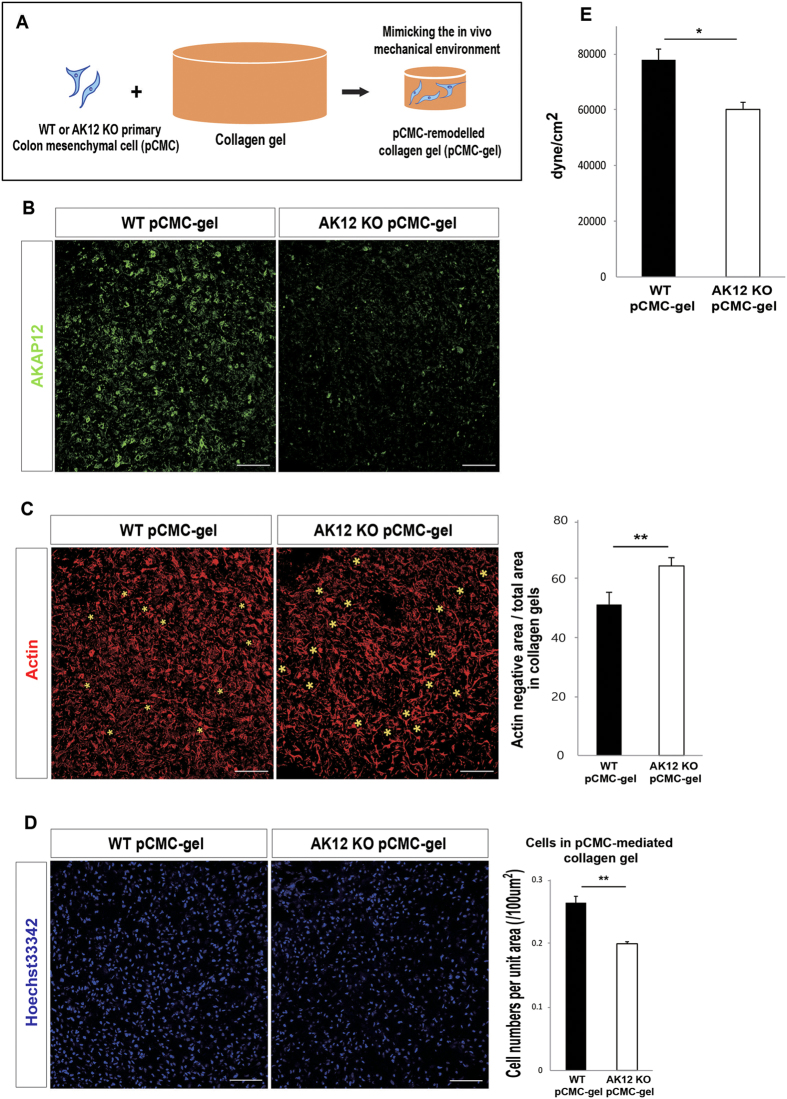
Mechanical difference between WT pCMC-gels and AKAP12 KO pCMC-gels.(A) Experimental design of collagen gel assay with pCMCs. To establish pCMC-gel, 7 × 105 WT or AKAP12 KO pCMCs were inserted in 3 mg/ml collagen gels, released from plate after incubated during 8 hr and then further incubated until 48 hr. (B) Immunostaining for AKAP12 in WT or AKAP12 KO pCMC-gels. Bars: 100 μm. (C) Actin negative area to total area of WT pCMC and AKAP12 KO pCMC-gels with was measured. Actin-negative area in representative images of each gels were marked by yellow asterisk with different size. Bars: 100 μm (D) Density of cells in collagen gels per each group were measured by calculate the number of cells per area. Bars: 100 μm (E) The storage modulus at 1% strain and at 1 Hz of fixed WT and AKAP12 KO pCMC-gels were averaged. (mean ± SEM, n = 6 per group). All panels, P** < 0.01, P* < 0.05. Error bars, s.e.m.